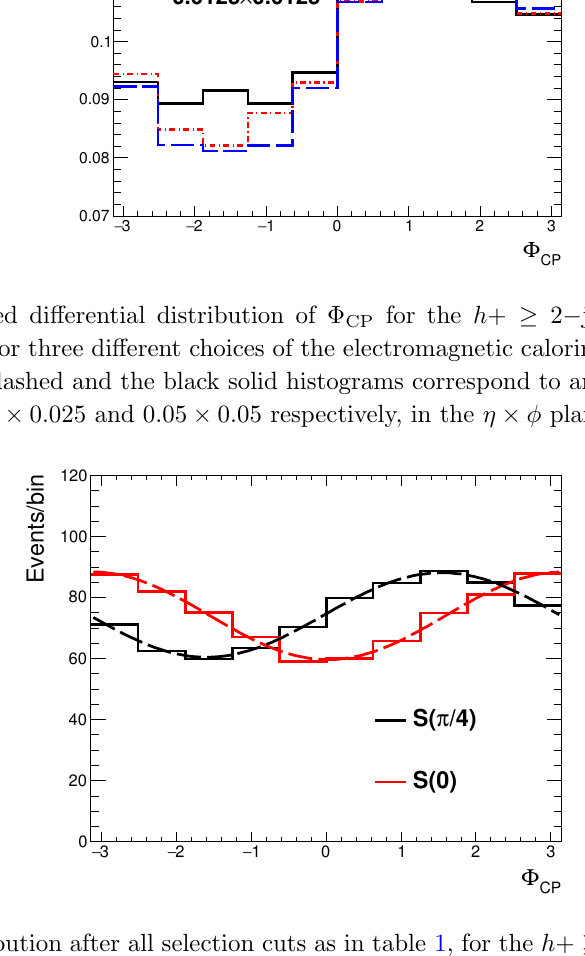
Figure 3 . (cid:8) CP distribution after all selection cuts as in table 1, for the h + (cid:21) 2 (cid:0) jets signal events, with the CP-mixing angle (cid:1) = 0 (red) and (cid:1) = (cid:25)= 4 (black). The event numbers correspond to an integrated luminosity of 3000 fb (cid:0) 1 at the 14 TeV